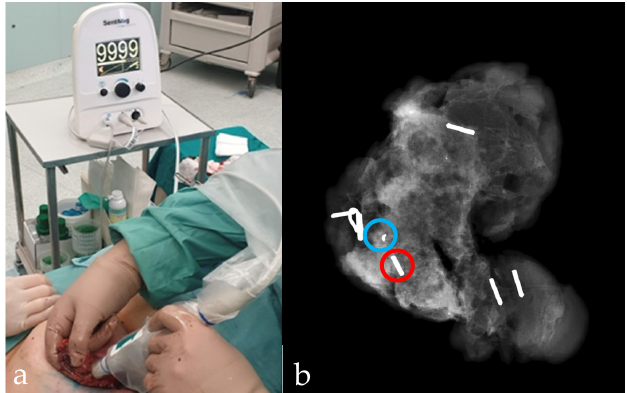
Figure 4. The SentiMag probe ( a ), used intraoperatively to locate the Magseed using a small and transient magnetic field that magnetizes the clip making it recognizable to the probe itself. In ( b ) radiographic examination of the surgical specimen shows the Magseed (red circle) adjacent to the previously clipped lesion (blue circle). b a